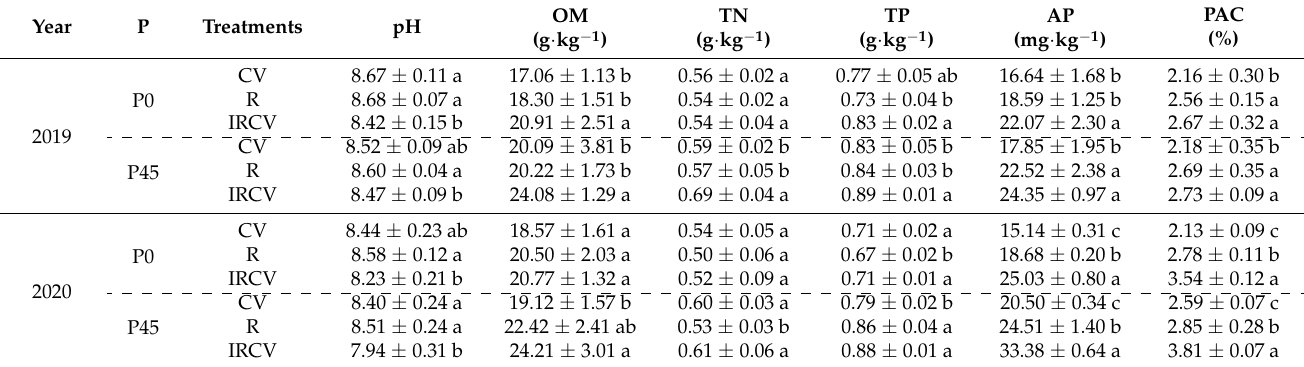
Table 4. Soil physiochemical properties in